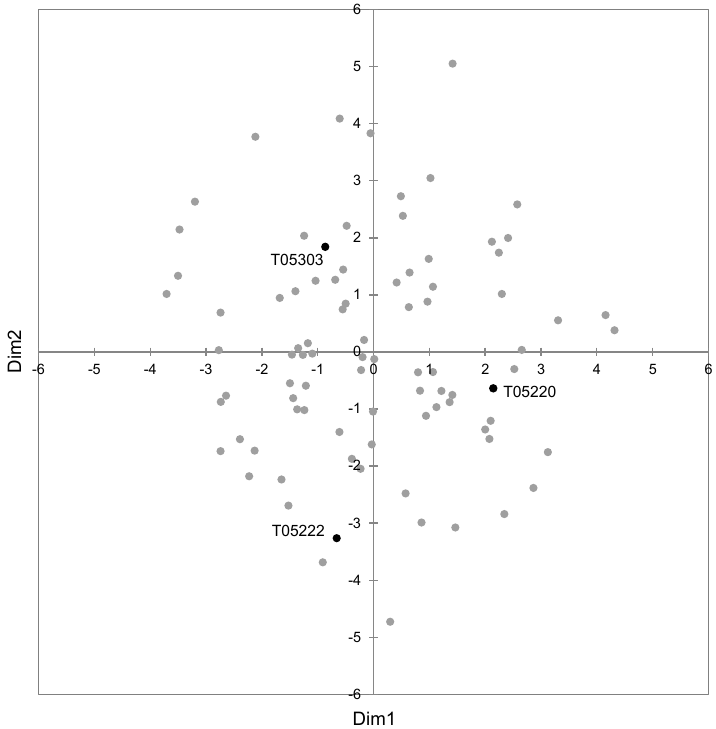
Figure 2. Multidimensional scaling (MDS) of 88 microsatellite-based Zymoseptoria tritici haplotypes sampled from five loca - tions in Algeria. Sensitive isolates are presented in clear grey and resistant isolates are presented in